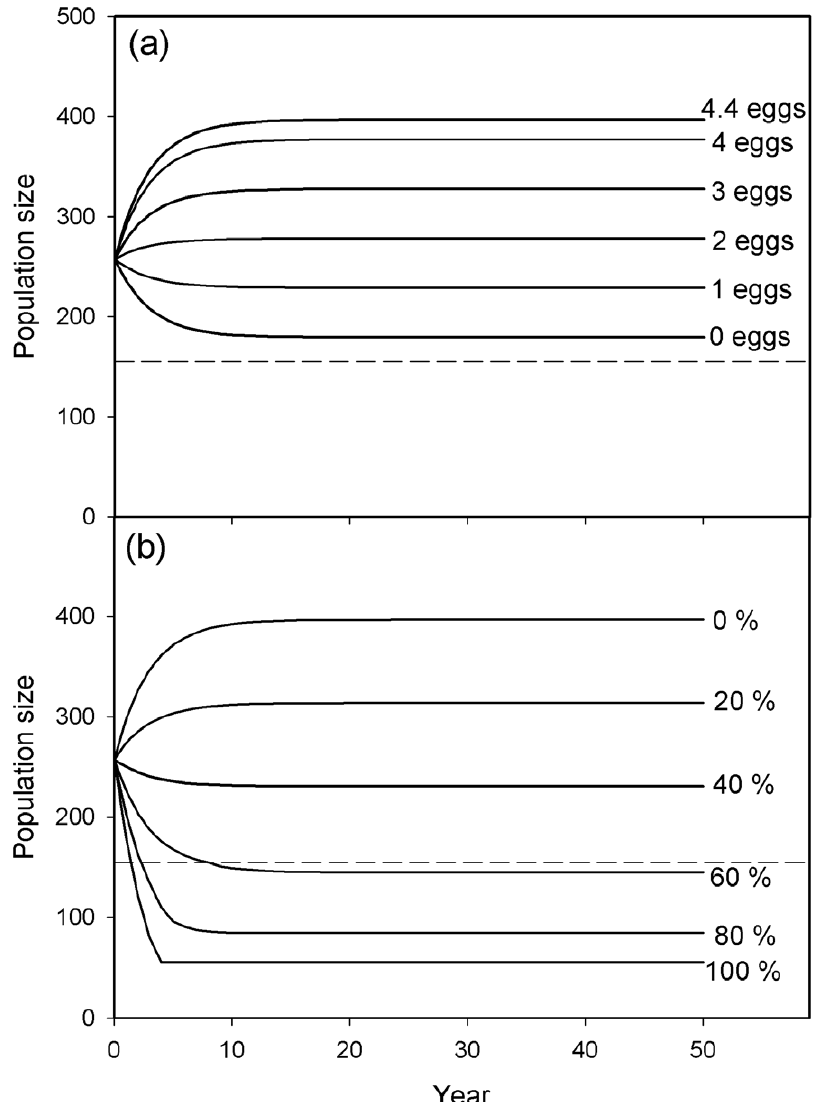
Figure 3. The projected population sizes when subject to sustained population management over a 50 year period. (a) Annual reductions in clutch size from 4.4 to 4, 3, 2, 1 or 0 eggs per nest. (b) Annual removal of 100, 80, 60, 40, 20 or 0% of the non-breeding individuals within the catchment. The dashed line represents the target threshold of 155 individuals.